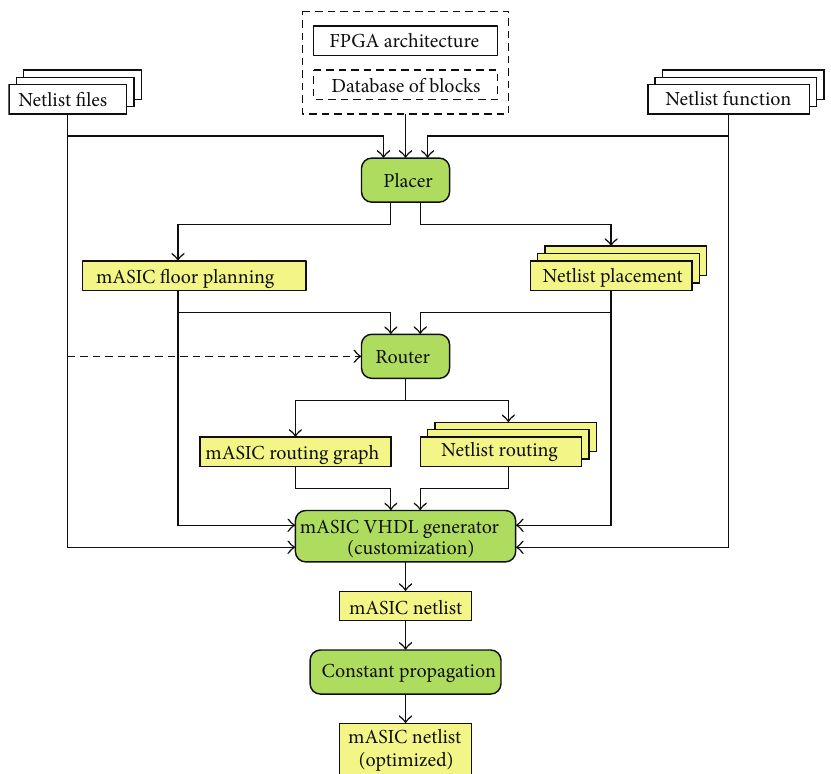
Figure 5: mASIC VHDL generation